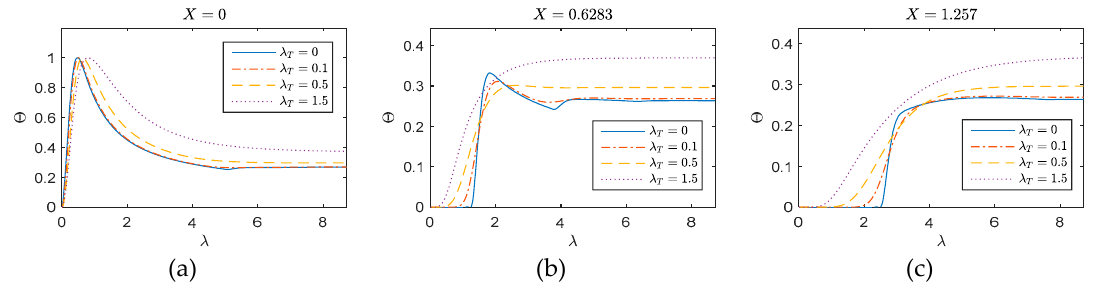
λ ff erent λ = 0; ( b ) X = 0.6283; ( c ) X = 1.257. : ( a ) X = 0; ( b ) X = 0.6283; ( c ) X = 1.257. Figure 5. WFEM performances for di T : ( a ) X